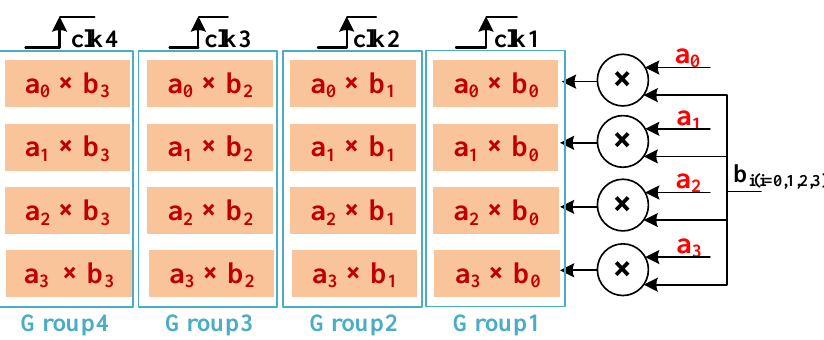
Figure 2. The multiplication process of the 64-bit IVS